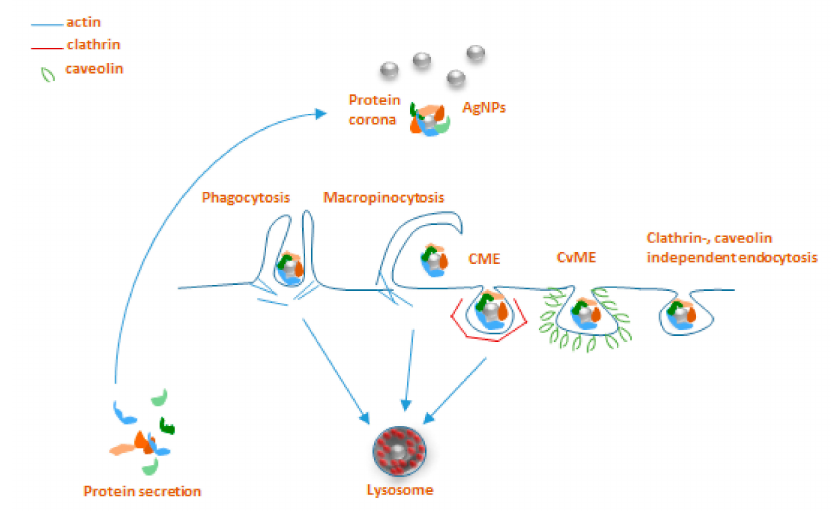
Figure 2. Main endocytosis pathways possibly involved in internalization of AgNPs: phagocytosis, macropinocytosis, clathrin-mediated endocytosis (CME), caveolin-mediated endocytosis (CvME), and clathrin / caveolin-independent